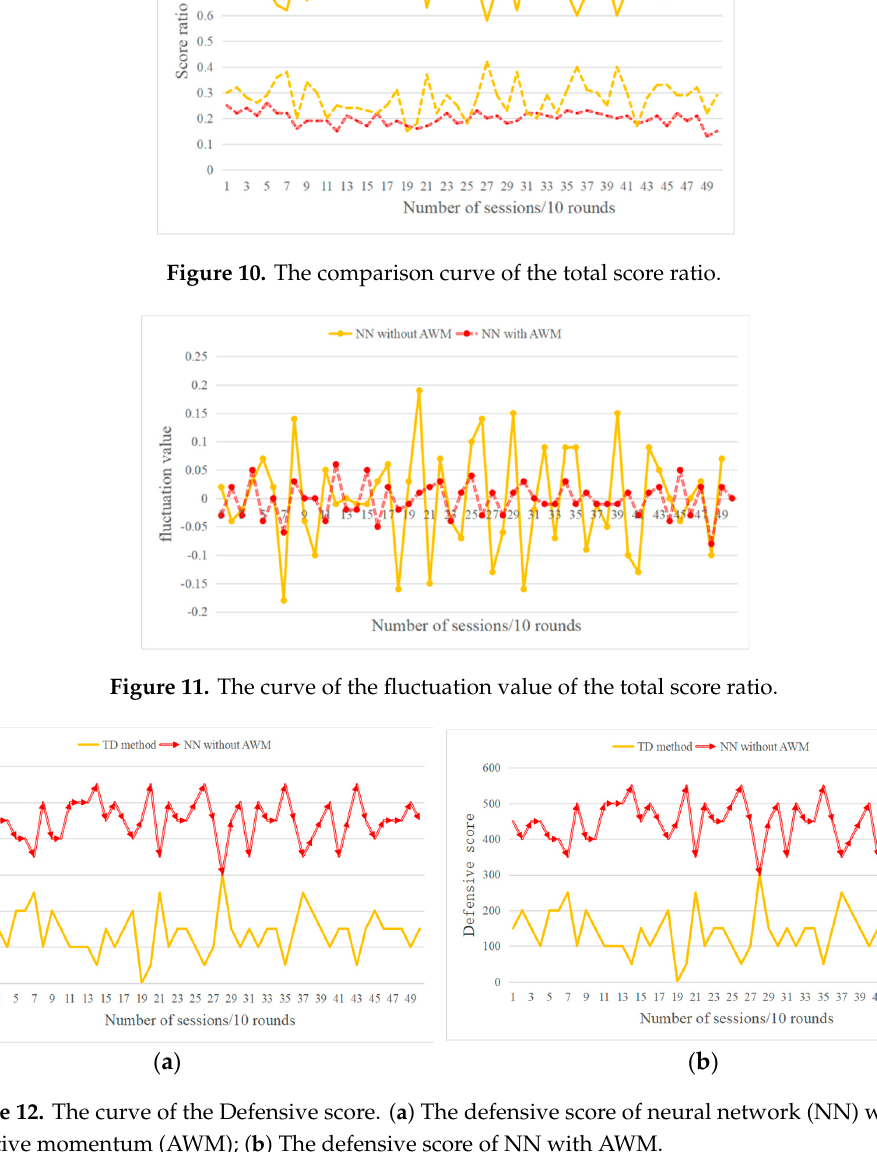
Figure 12. The curve of the Defensive score. ( a ) The defensive score of neural network (NN) without adaptive momentum (AWM); ( b ) The defensive score of NN with AWM.